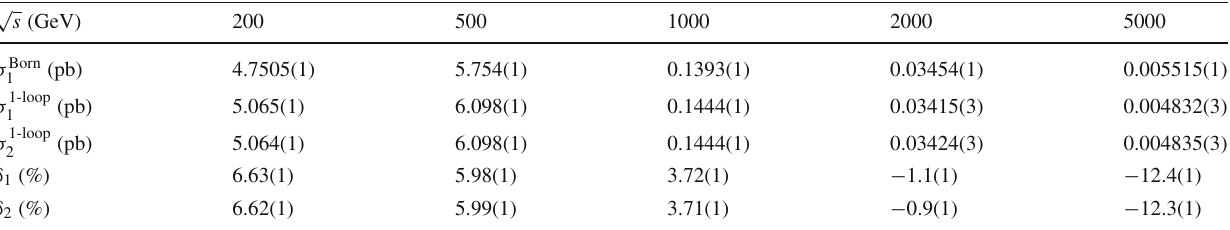
Table 5 Comparison of the Born and one-loop cross sections of the annihilation channel ¯ uu → Z γ(γ) calculated with different values of the soft/hard separation parameter ¯ ω √